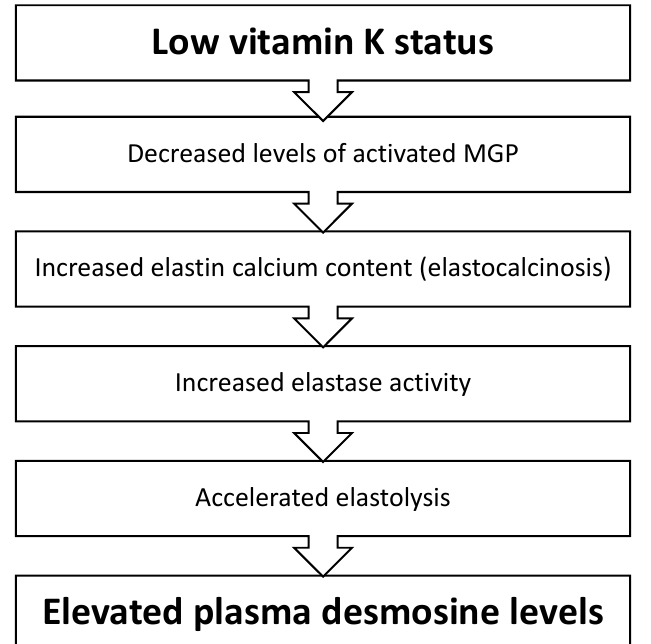
Figure 1. Proposed mechanism by which low vitamin K status leads to the acceleration of elastin degradation reflected by elevated plasma desmosine levels. Low vitamin K status will lead to impaired Matrix Gla Protein (MGP) activation and, subsequently, to an increased calcium content within elastin fibres. Elastin calcification causes elastin degradation. During the process of elastin degradation, desmosine is released from crosslinked elastin fibres and leaks from the extracellular matrix to the blood